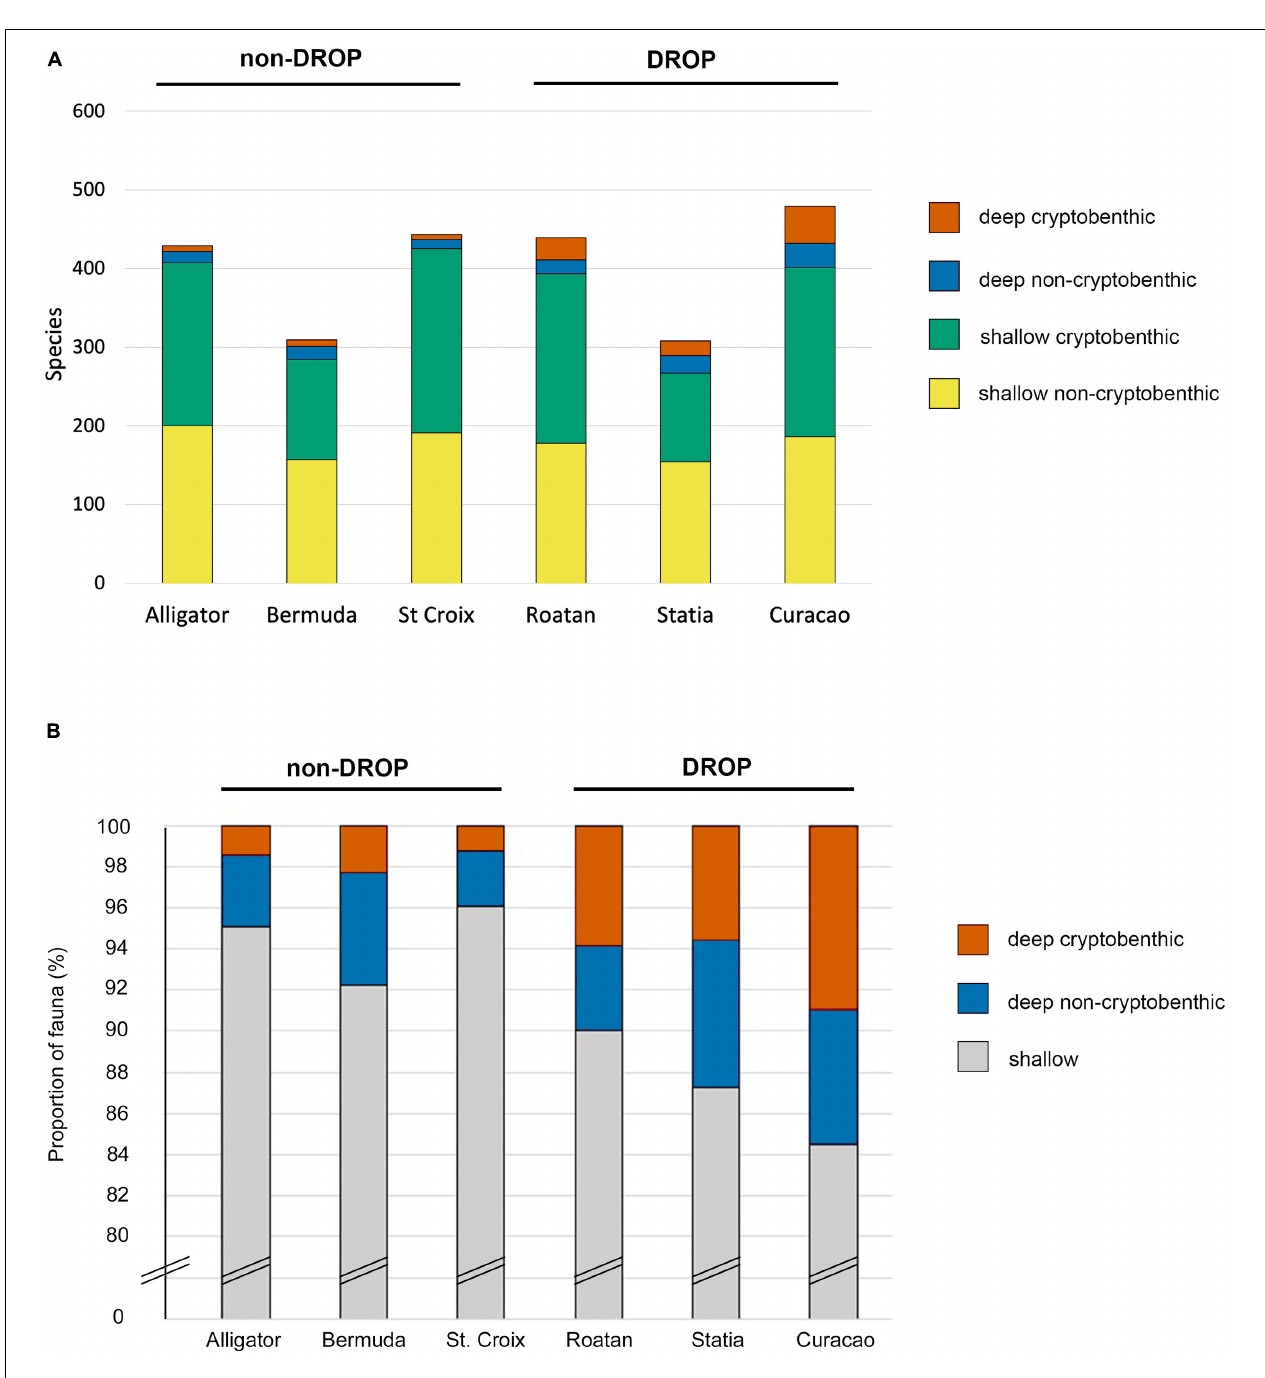
FIGURE 2 | Abundance of deep and shallow cryptobenthic fishes in the faunas of six sites. (A) Numbers of species of cryptobenthic and other non-pelagic species in the shallow and deep sectors of the faunas. (B) Relative abundance of cryptobenthic vs. other non-pelagic species in the deep faunas of six islands. Data in Supplementary Table 1